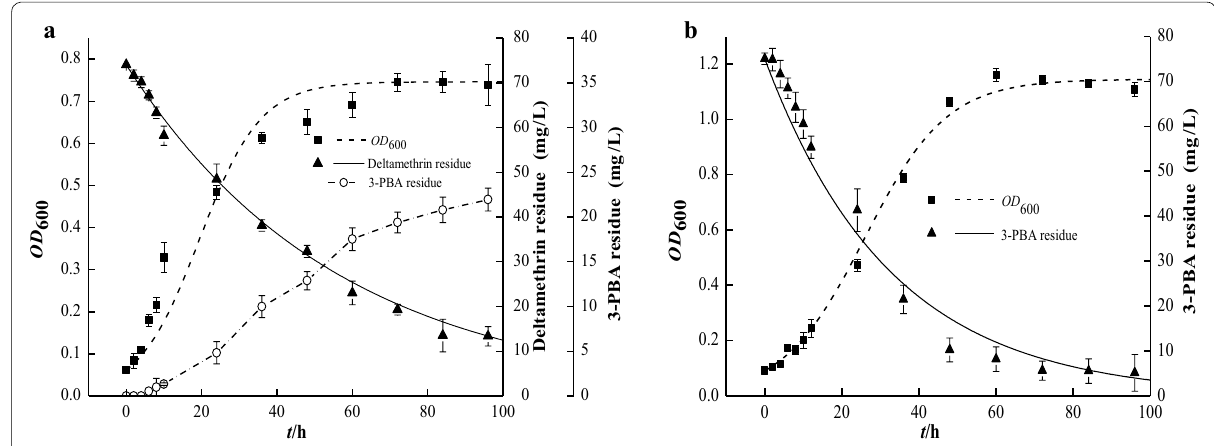
Fig. 1 Growth and degradation curve of A. junii LH-1-1 a and K. pneumoniae BPBA052